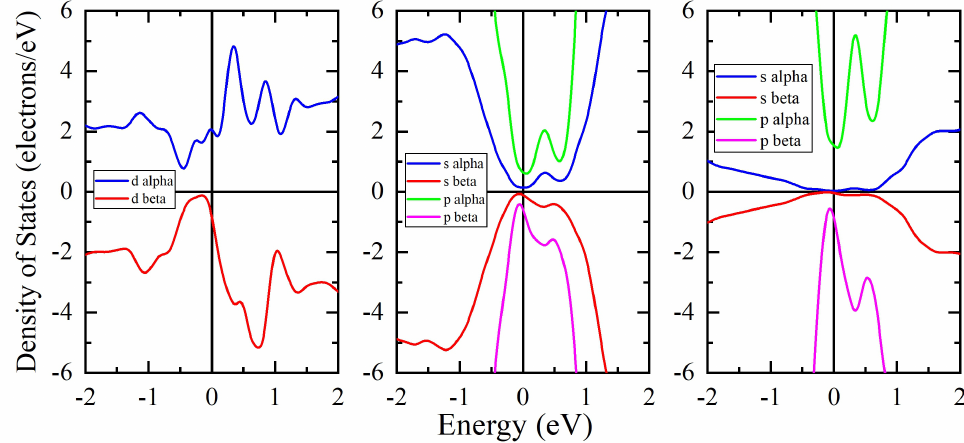
Figure 4. Partial densities of Mo d -states ( left ), As sp -states ( center ) and of S sp -states ( right ) for mq-GOpt a-As 2 S 3 :Mo structure.